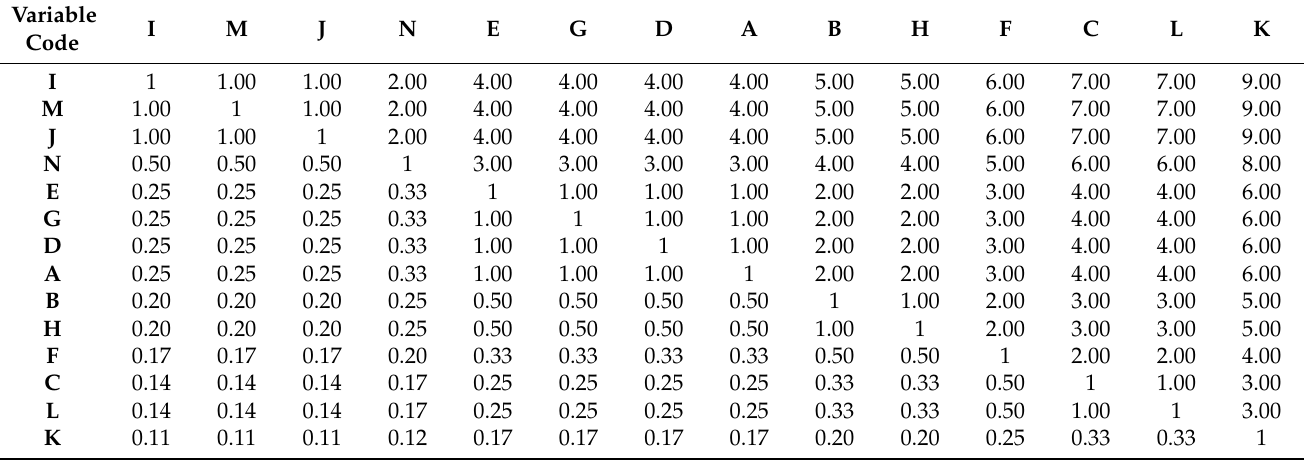
Table 9. Pairwise comparison matrix generated by the analytic hierarchy process